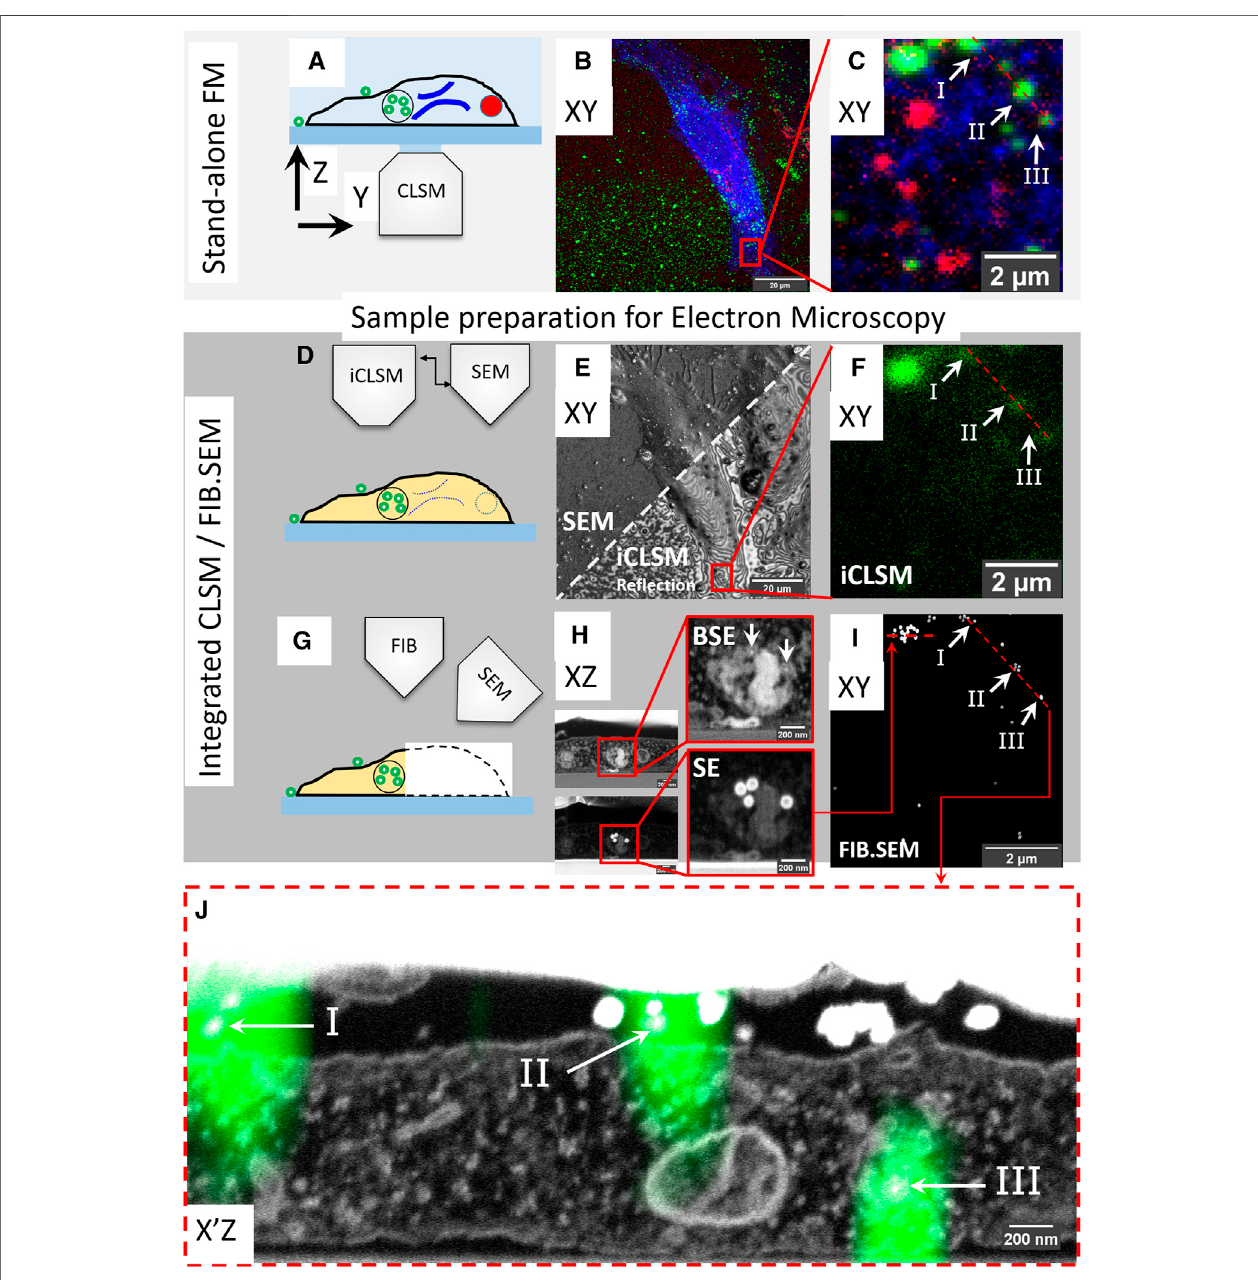
FIGURE 1 | High accuracy 3D correlation work fl ow from live-cell-to-volume EM with iCLSM. (A – C) Live-cell imaging and CLSM. (A) Live-cell imaging of cells on gridded coverslips instand-alone CLSM followed by z-stack recordingof fi xed cells. (B) Maximum intensity projection of the CLSM Z-stack. ER(blue),active lysosomes (red), and endocytic fi ducial particles (green). (C) The selected ROI, red square, within the cell in (B) . (D – F) Correlation with iCLSM. (D) Locating the ROI in the FIB.SEM chamber by iCLSM after EM preparation. (E) Re fl ection mode imaging in iCLSM to navigate through the gridded glass coverslip and fast-tracking of ROI by cell shape. iCLSM re fl ection image (lower half) relates easily with SEM (upper half). (F) The ROI can be localized by the fl uorescence mode of iCLSM. The (remaining) fl uorescence signal of the fi ducial nanoparticles is used for correlation back to the CLSM image in (C) . (G – I) 3D FIB.SEM acquisition of the re-established ROI. (H) Slice- by-slice acquisition is performed with backscattered electrons (BSE, top) and secondary electrons (SE, bottom). Fiducial nanoparticles have a clear signature of a bright backscattering core (top) and shell in secondary electrons (bottom). (I) They can be thus fi ltered from the acquired data stack to aid precise correlation of ROI between CLSMandFIB.SEM.Notetheone-to-onecorrespondencebetweenpanels (C,F,I) . (J) Overlayof3DCLSMdatafromthe fi xedcellandthe3DFIB/SEMdata.EMimage corresponds to the plane of red dashed line in (C,F,I) .